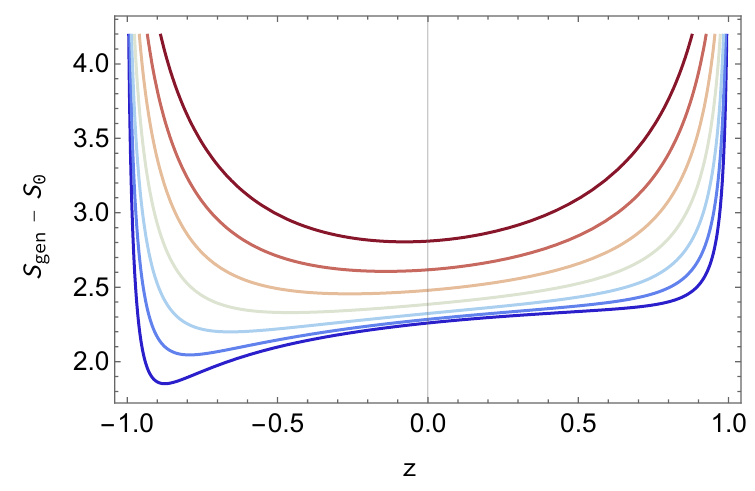
Figure 1 . Generalized entropy S m + φ − φ 0 as a function of the real coordinate z . Here S m is the matter entropy of an interval [ − 1 + (cid:15) 1 / 2 , z ] . For large values of φ h , there is a QES near the horizon. As φ r gets smaller, the QES shifts closer to the left